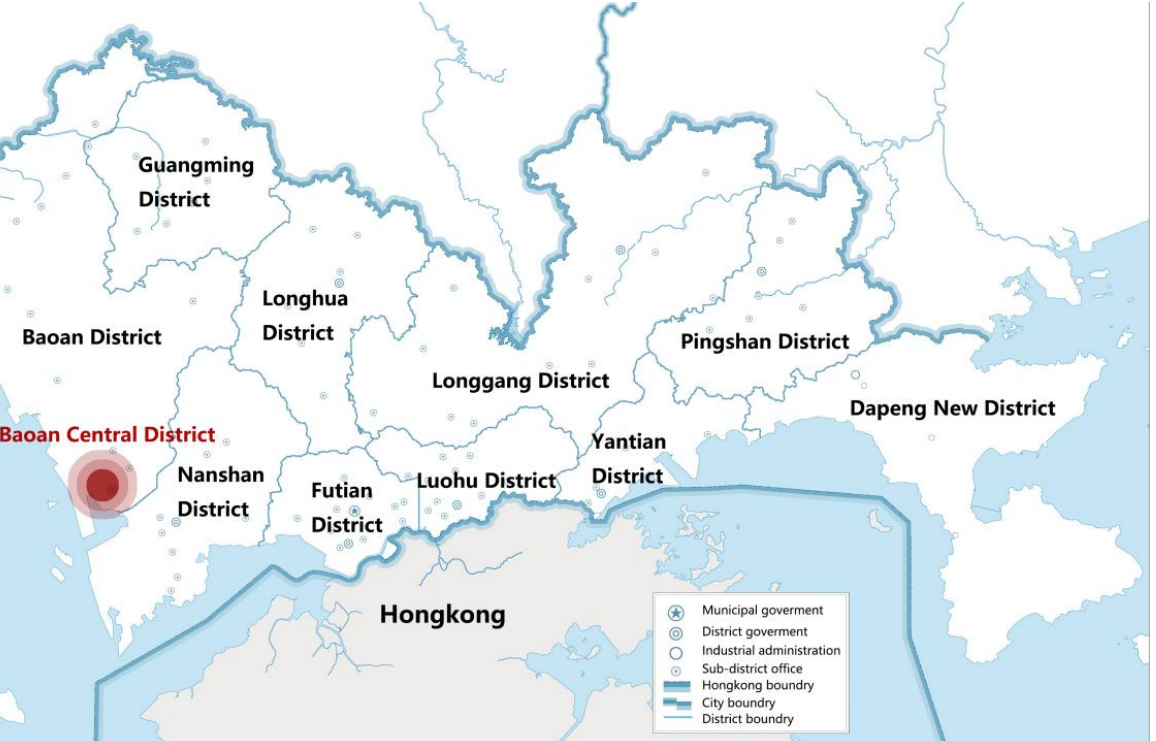
Figure 3. Typical office and residential building in Bao’an district. The figure belongs to the follow- ing source: Beike Housing. Available online: https://bj.ke.com (accessed on 18 August 2022). Due to the unbalanced supply-and-demand relationships between office and resi- dential land, Shenzhen municipal government issued Measures for Further Increasing the Supply of Residential Land (Exposure Draft) in July 2021 [72]. It proposes that in the future, Shenzhen will gradually increase the scale of residential land and public facilities and en- sure that the per capita housing area of permanent residents reaches over 40 square meters by 2035. It also encourages the regeneration and transformation of existing office build- ings into residential or long-term rental apartments. Overall, our case is a rational choice, which will make a difference to the economic valuation of the partial change from office buildings into residential space. These also meet the needs of urban regeneration. 3.2. Methods This study argued to separately estimate the valuation change of the development right of spaces in urban regeneration, instead of carrying out the valuation based on the average floor. It results from the different implicit matching degrees between spaces and